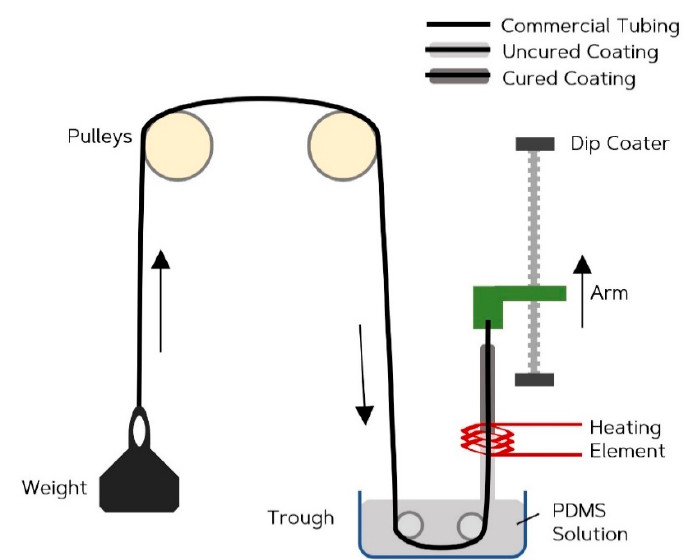
Figure 1. Continuous dip coating fabrication method.